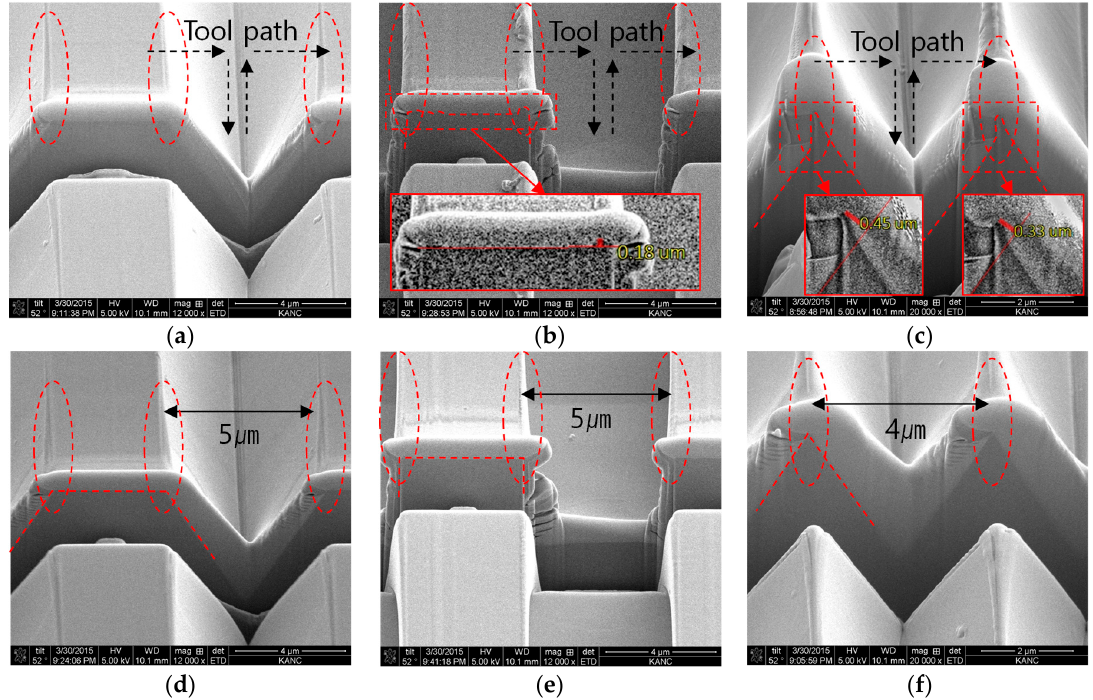
Figure 7. SEM photos for the three shapes of the machined microstructures: depth of cut of 1.0 µm ( a – c ) and 0.1 µm ( d – f ).